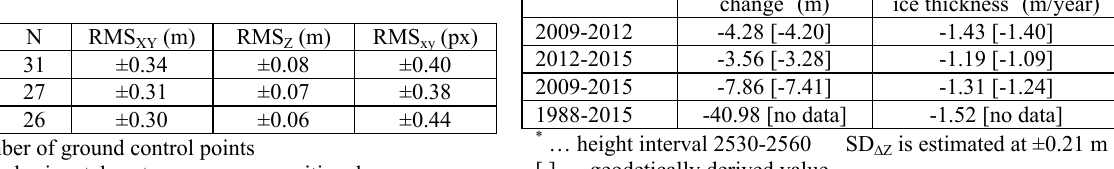
Table 7. Change in surface height/ice thickness along the longitudinal profile.